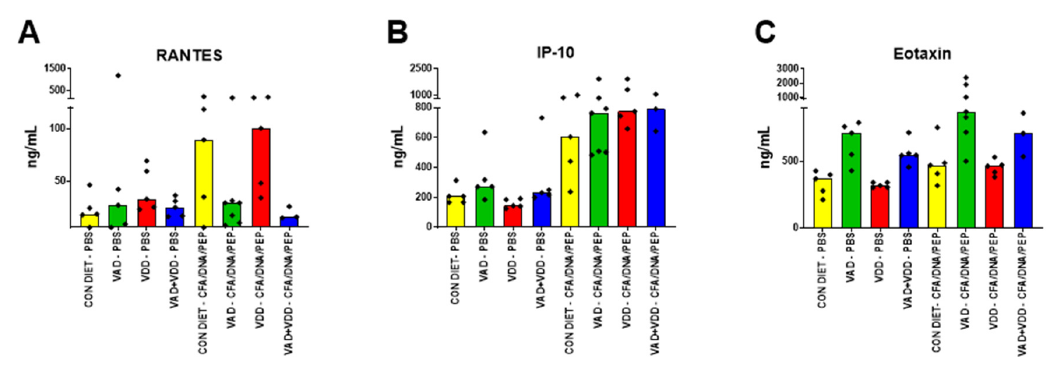
Figure 2. Changes in the blood cytokines / chemokines based on diets. Results are shown from a representative experiment. Mice received consecutive injections, either with PBS or with complete and incomplete Freund’s adjuvant emulsified with DNA + Fus-1 peptide (CFA / DNA / PEP). Mice were primed and boosted and sampled approximately 3 – 4 weeks after the booster. Results are shown for regulated upon activation, normal T cell expressed and secreted (RANTES, ( A )), interferon γ -inducible protein 10 (IP-10, ( B )), and eotaxin ( C ). Yellow = control mice (mice on the vitamin-replete, control diet, “CON DIET”); green = vitamin A deficient (VAD) mice; red = vitamin D deficient (VDD) mice; blue = double deficient (VAD+VDD) mice. Each symbol represents a different mouse, with medians indicated by bar heights.